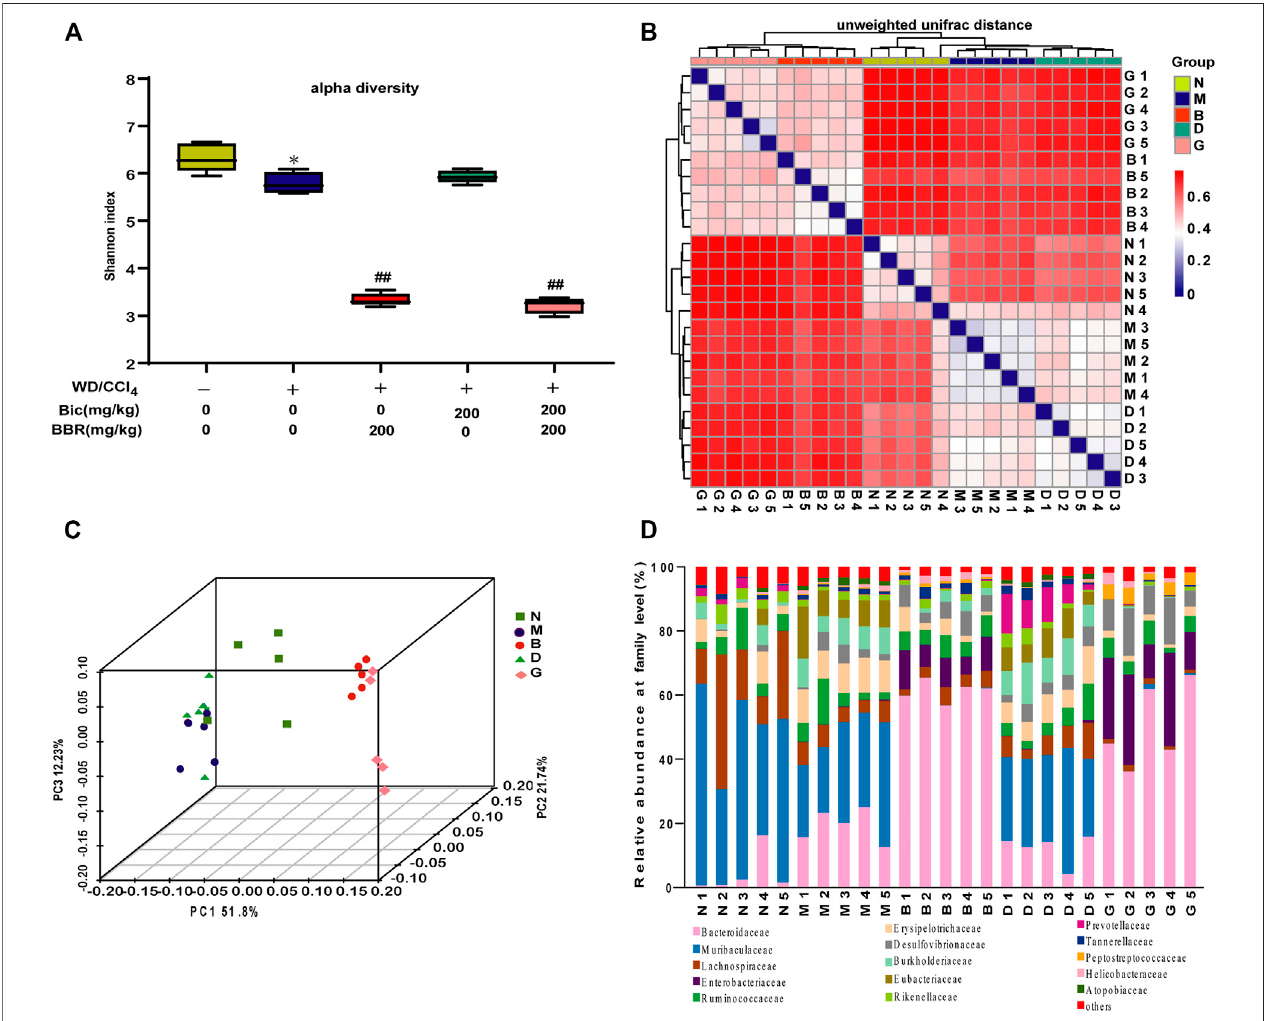
FIGURE 5 | Berberine but not bicyclol modulates the composition of gut microbiota in WD/CCl 4 -induced NASH mice. A total of 25 male C57BL/6J mice fecal sampleswith fi veineach representativegroupwerecollectedandanalyzed using 16SrRNAgenesequencing. (A) Thealpha diversity ofeach groupwasobtainedusing the Shannon index. (B – C) The beta diversity among samples was obtained using the unweighted UniFrac diversity distance (B) and PCoA (C) of gut microbiota. (D – E) Therelativeabundanceofbacteriaatfamily (D) andgenus (E) level. (F) Representativehistogramofthemostabundantgutmicrobiotaatthefamilyandgenuslevel. (G) Prediction of lipid metabolism-related microbiome function based on KEGG database. *p < 0.05, **p < 0.01 vs. the control group; # p < 0.05, ## p < 0.01 vs. the WD/